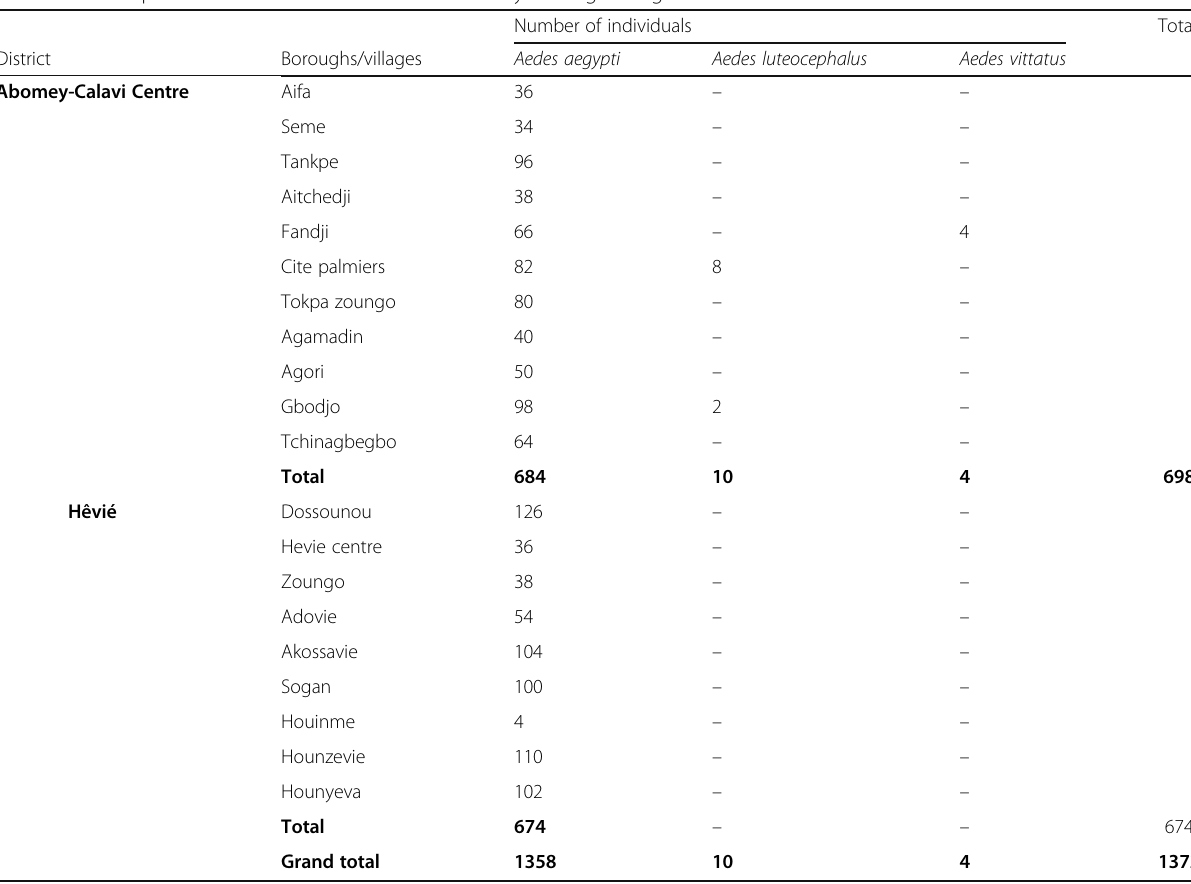
Number of individuals